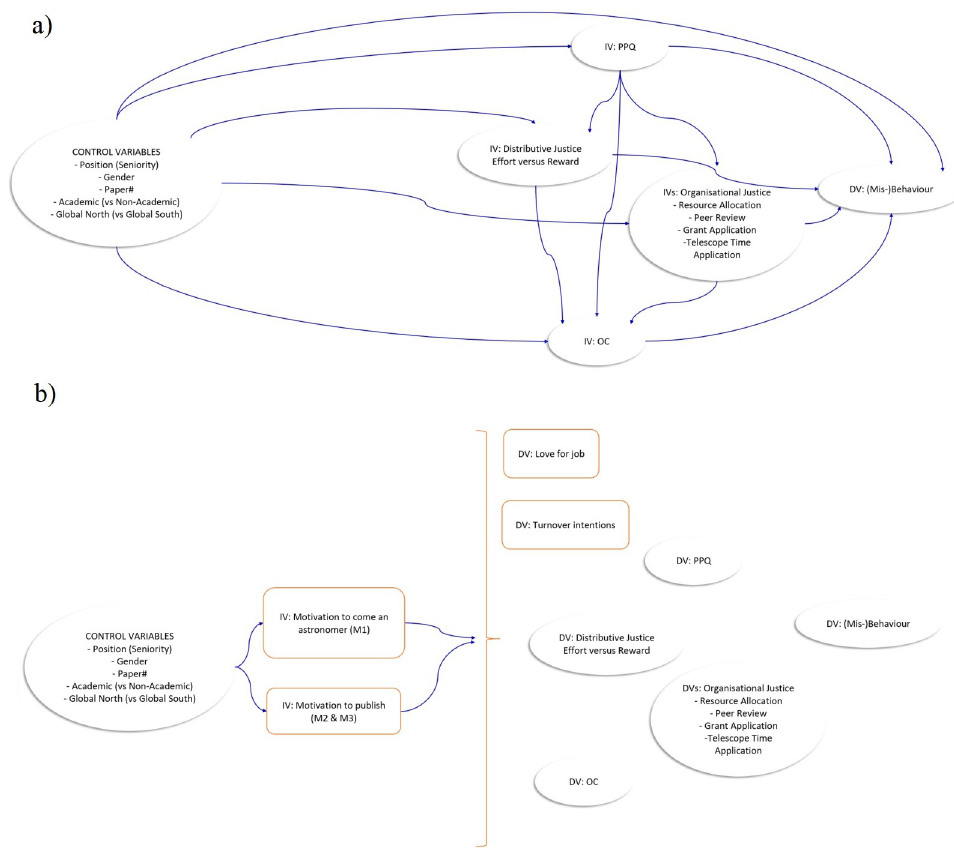
Fig 2. Comparison of the model used in [12] and this study’s enhanced model, representing control, independent (IV) and dependent variables (DV). Arrows indicate that a construct (arrowhead) is being regressed onto another construct (arrow start). a) corresponds to Fig 1 in [12]; used with author’s permission, and format slightly adapted for better comparability]. b) corresponds to the model used in this study. For better readability, the curly bracket substitutes the arrows going from each control variable and IV to each DV. Those IVs and DVs which enhance the model represented by a) are highlighted as a square (and orange) compared to the ovals used in a).